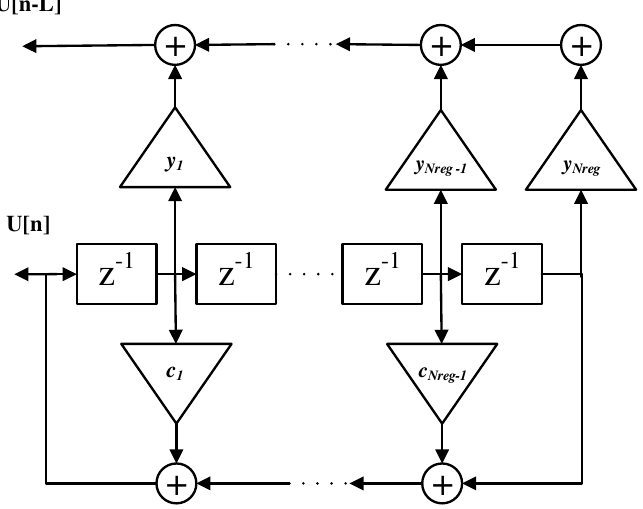
Figure 3. Schematic of the final LFSR based symbol